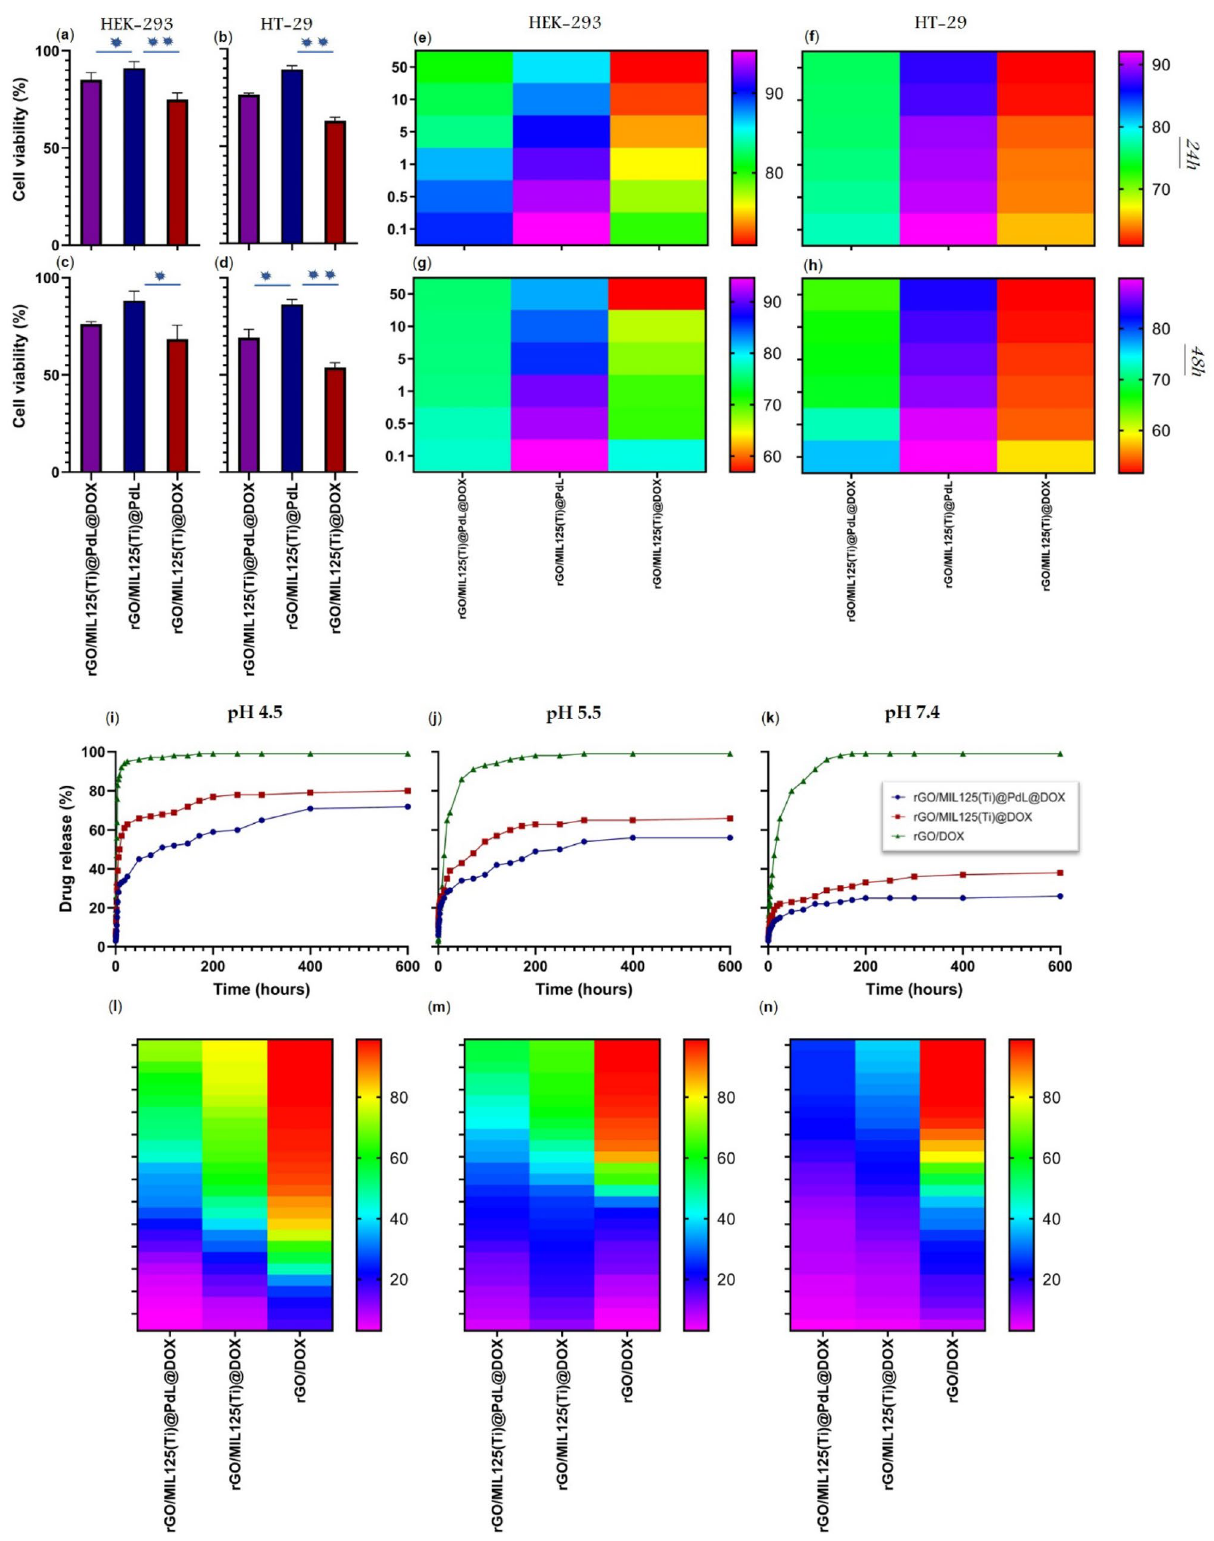
Figure 5. The MTT assay median results after 24 and 48 h of treatment on the HEK-293 ( a and c ) and HT-29 cell lines ( b and d ). The MTT assay’s heat map results in different concentrations (0.1–50 mg/mL) of different nanocarriers and nanomaterials on the HEK-293 ( e and g ) and HT-29 ( f and h ) after 24 and 48 h of treatment. The drug release profile (time-dependent characteristic) at pH (4.5), (5.5), and (7.4) showed in i, j, and k respectively. The 2D heat-map at pH (4.5, 5.5, and 7.2) drug release profile has been revealed at ( l, m, and n ). (The bluish and the reddish color can indicate the lowest and the highest drug release percentage). *p value < 0.05 and **p value <